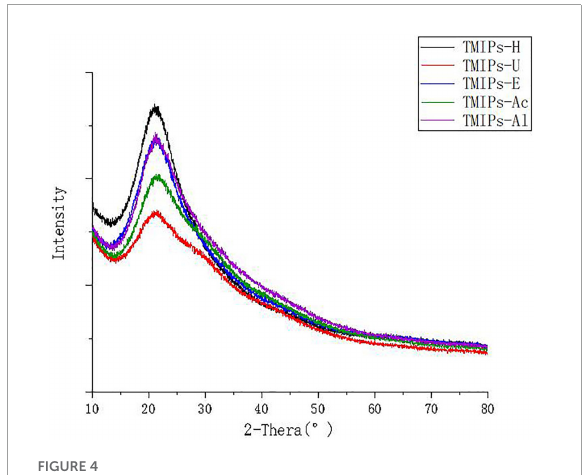
FIGURE4 XRD analysis of different polysaccharides from